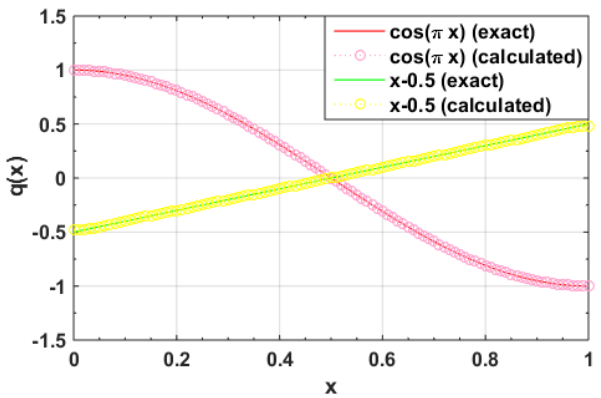
Figure 5. Exact and reconstructed potentials q ( x ) = cos ( π x ) and q ( x ) = x −